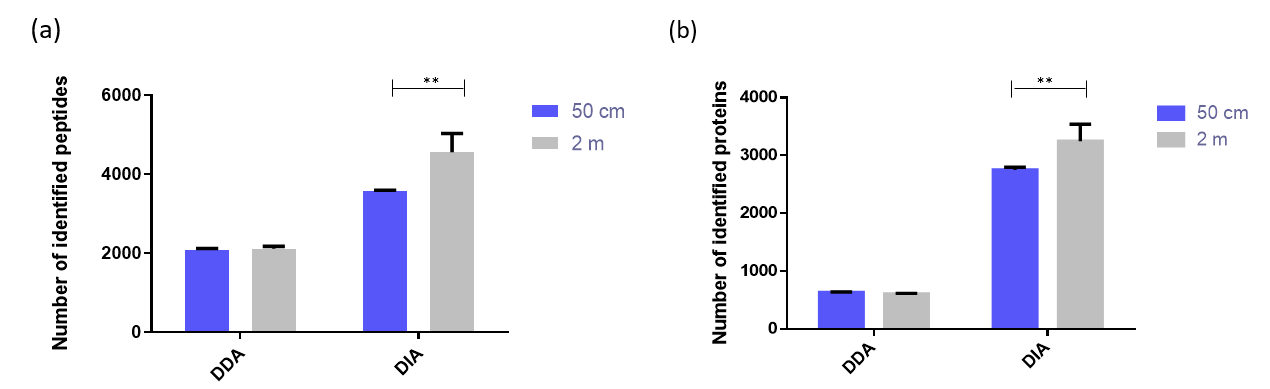
Figure 4. Comparison of the number of identified peptides ( a ) and proteins ( b ) using the 50 cm and 2 m long µPAC columns ( n = 3). ** ( p -value < 0.01). Sample: 500 ng Pierce™ HeLa Protein Digest Standard.